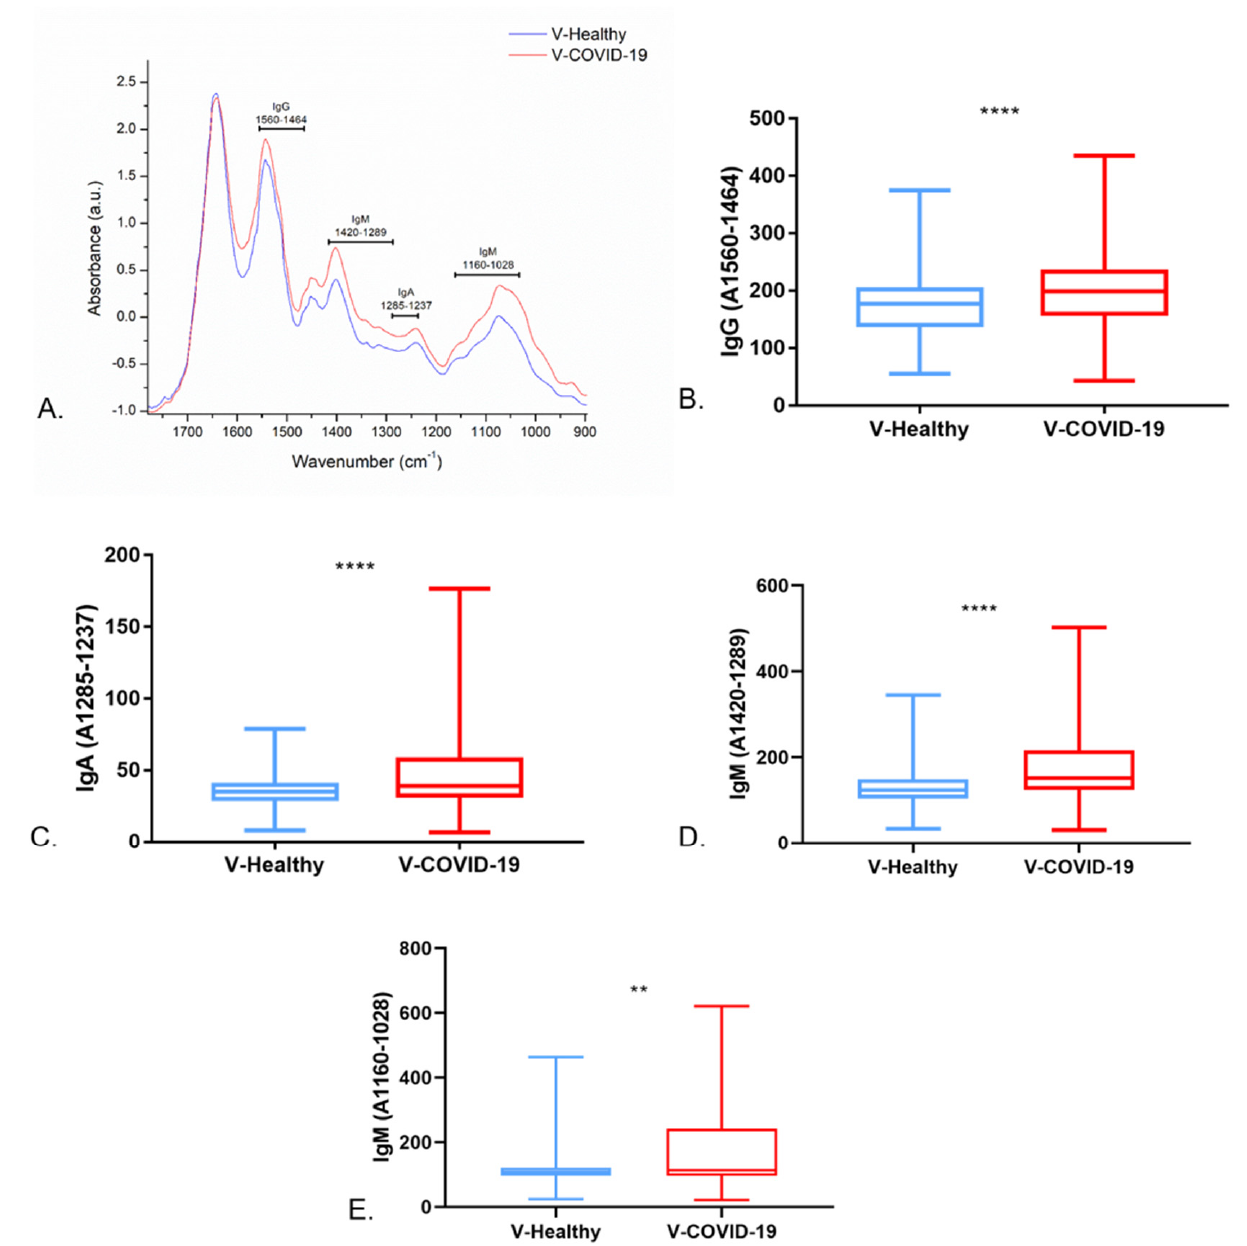
Figure 3. Immunoglobulins content analysis studied through FTIR. Identification of immunoglobulins in the FTIR spectra of saliva samples ( A ), integrated areas of IgG ( B ), integrated areas of IgA ( C ), and integrated areas of IgM ( D , E ). ** p < 0.05 and **** p < 0.0005.